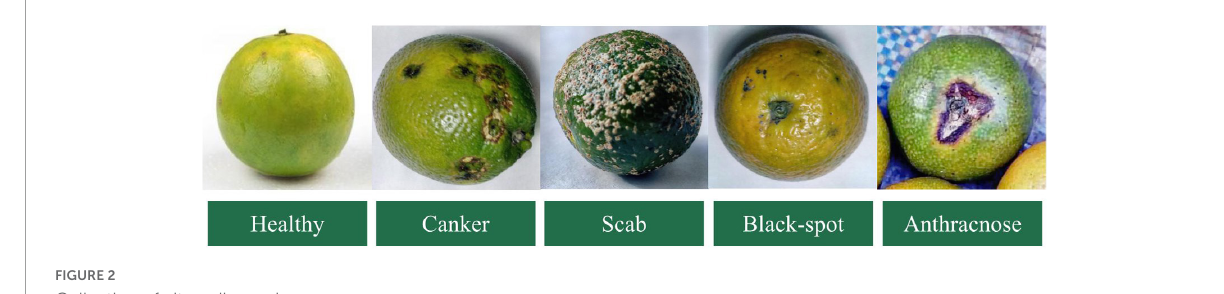
FIGURE2 Collection of citrus disease images.